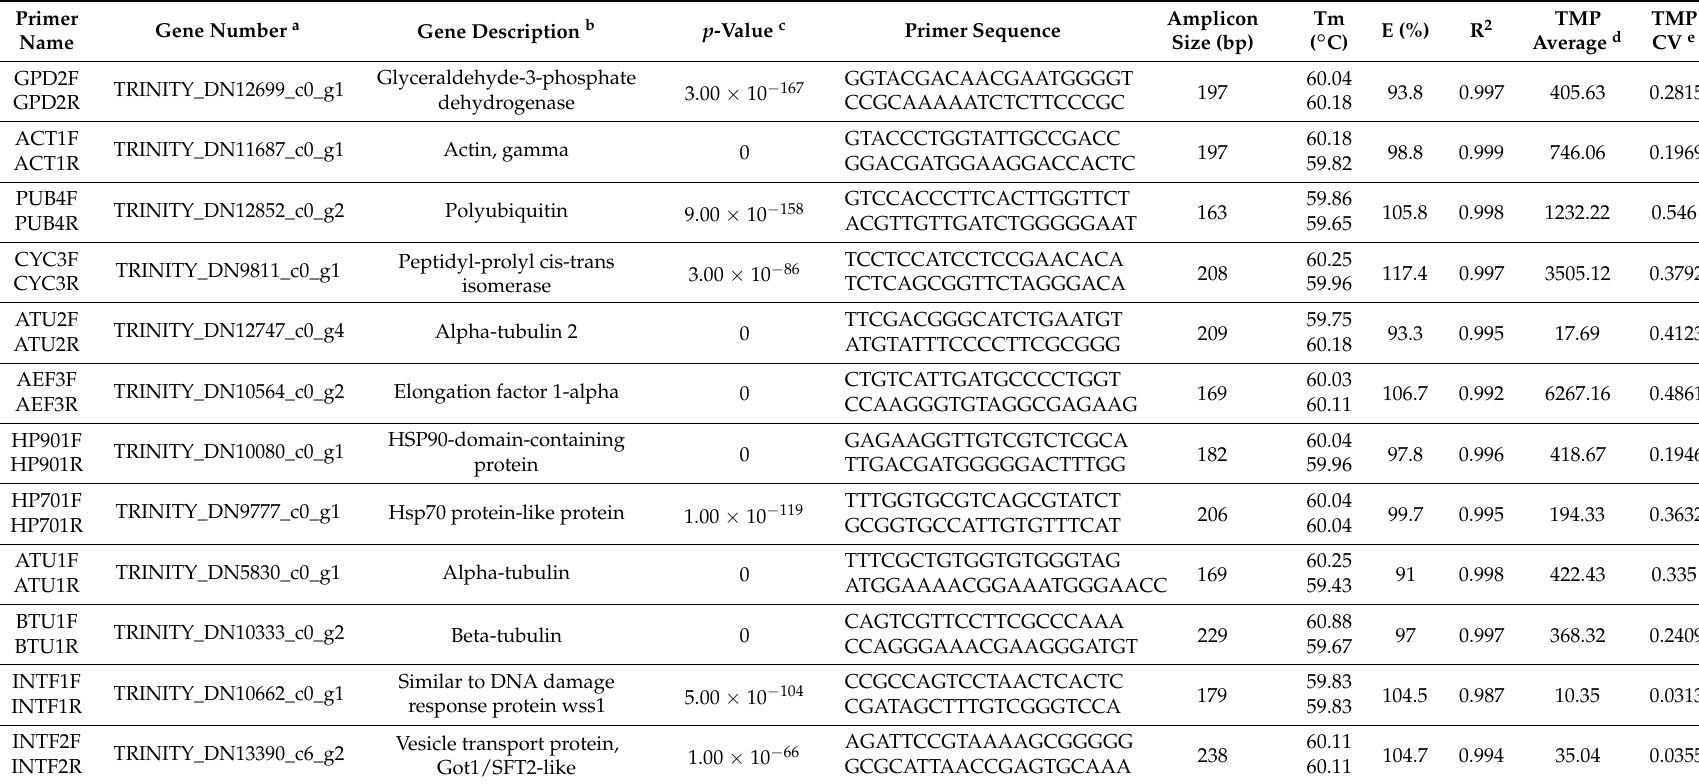
Table 1. The candidate internal control genes for gene expression evaluation in this